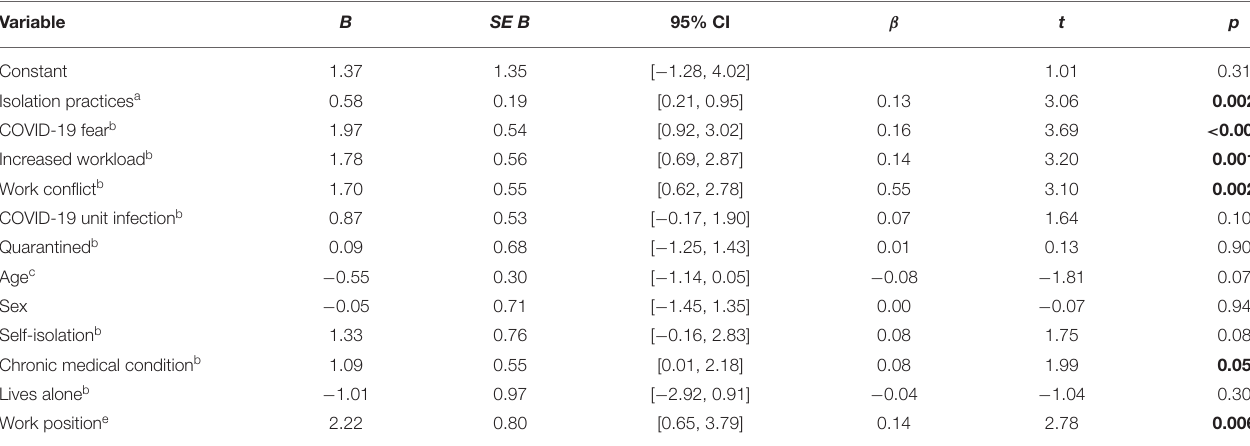
TABLE 9 | Multiple linear regression analysis for worker variables predicting IES-R posttraumatic stress—avoidance score. Variable B SE B 95%